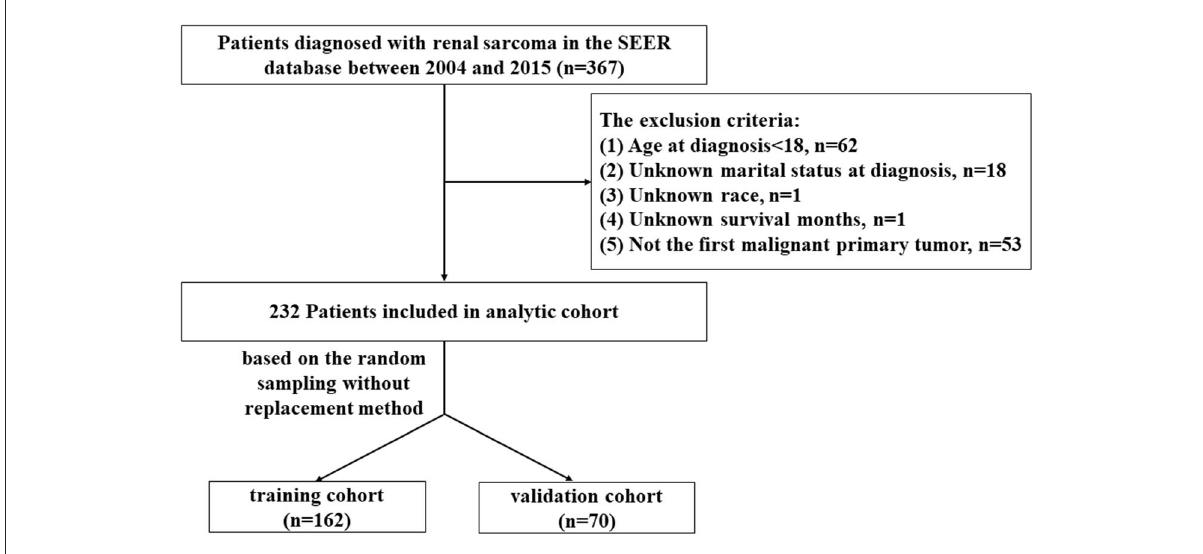
FIGURE1 The study flow chart of the selection